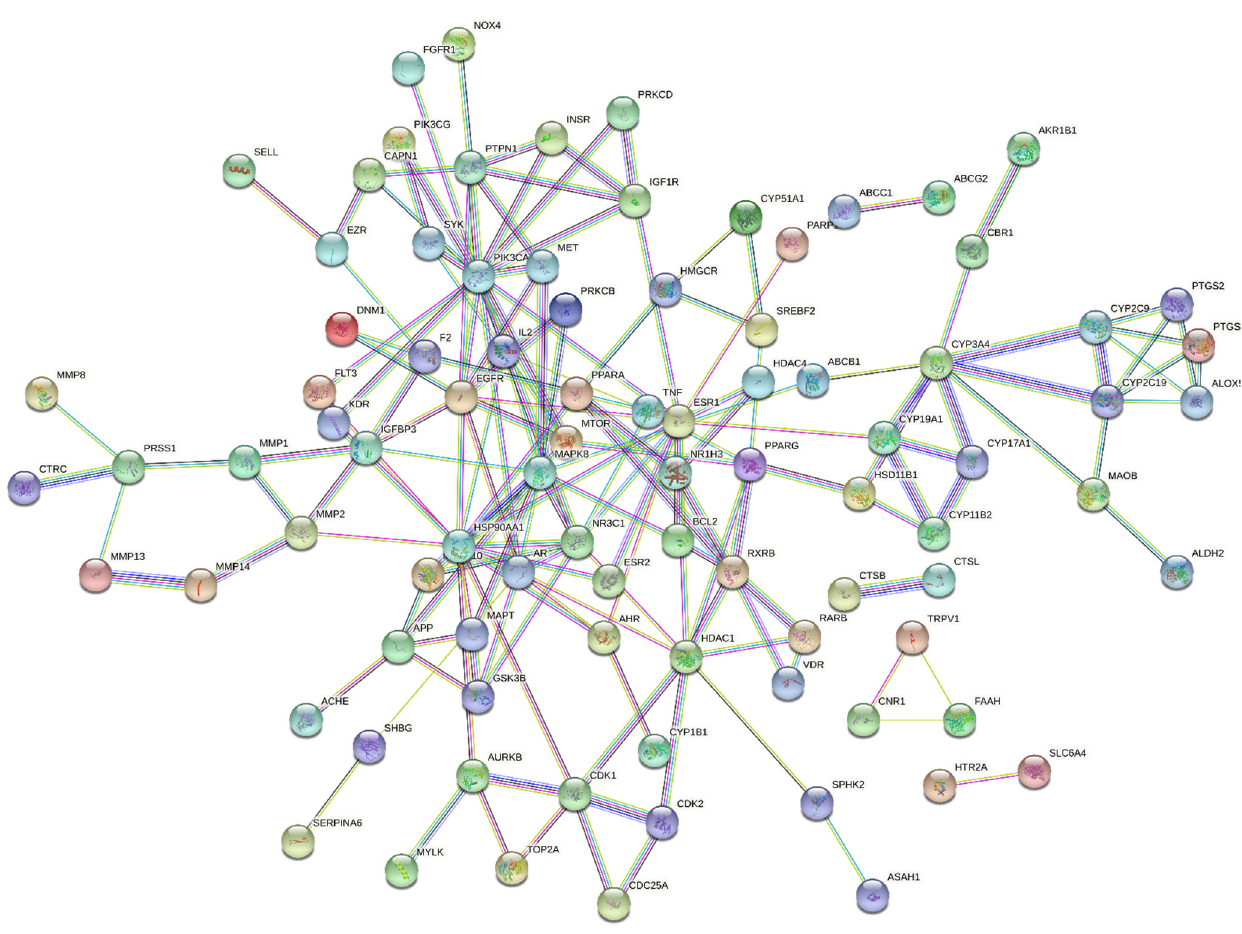
Figure 3. The PPI network constructed by STRING database.